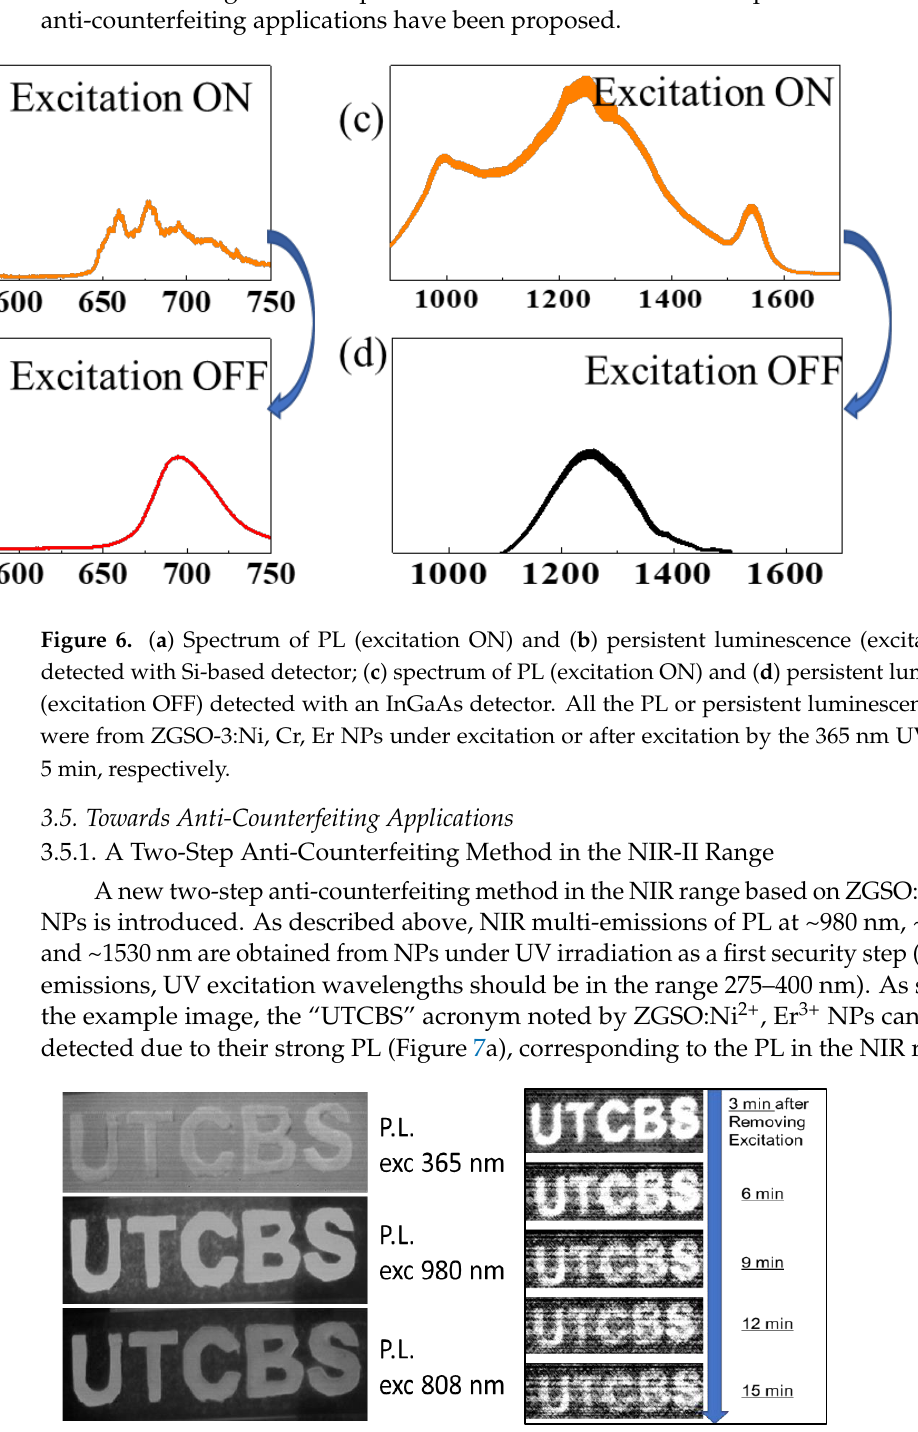
Figure 5. ( a ) Persistent luminescence spectra of the ZGSO-0 – ZGSO-6 samples (1 min after ceasing UV excitation). ( b ) Corresponding decay curves of the ZGSO-1, ZGSO-3, ZGSO-5 samples after removing excitation. The inset presents the time dependence of the NIR persistent luminescence intensity of emission wavelength at 1300 nm and 1530 nm for Er 3+ , Ni 2+ co-doped ZGSO-3. The emission at 1530 nm is at around the background level. All samples were excited using a 365 nm UV lamp for 5 min.